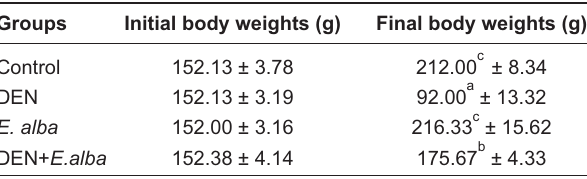
E.alba Table-2: Effect of on serum total protein, albumin and globulin of control and treated animals (mean±SE).